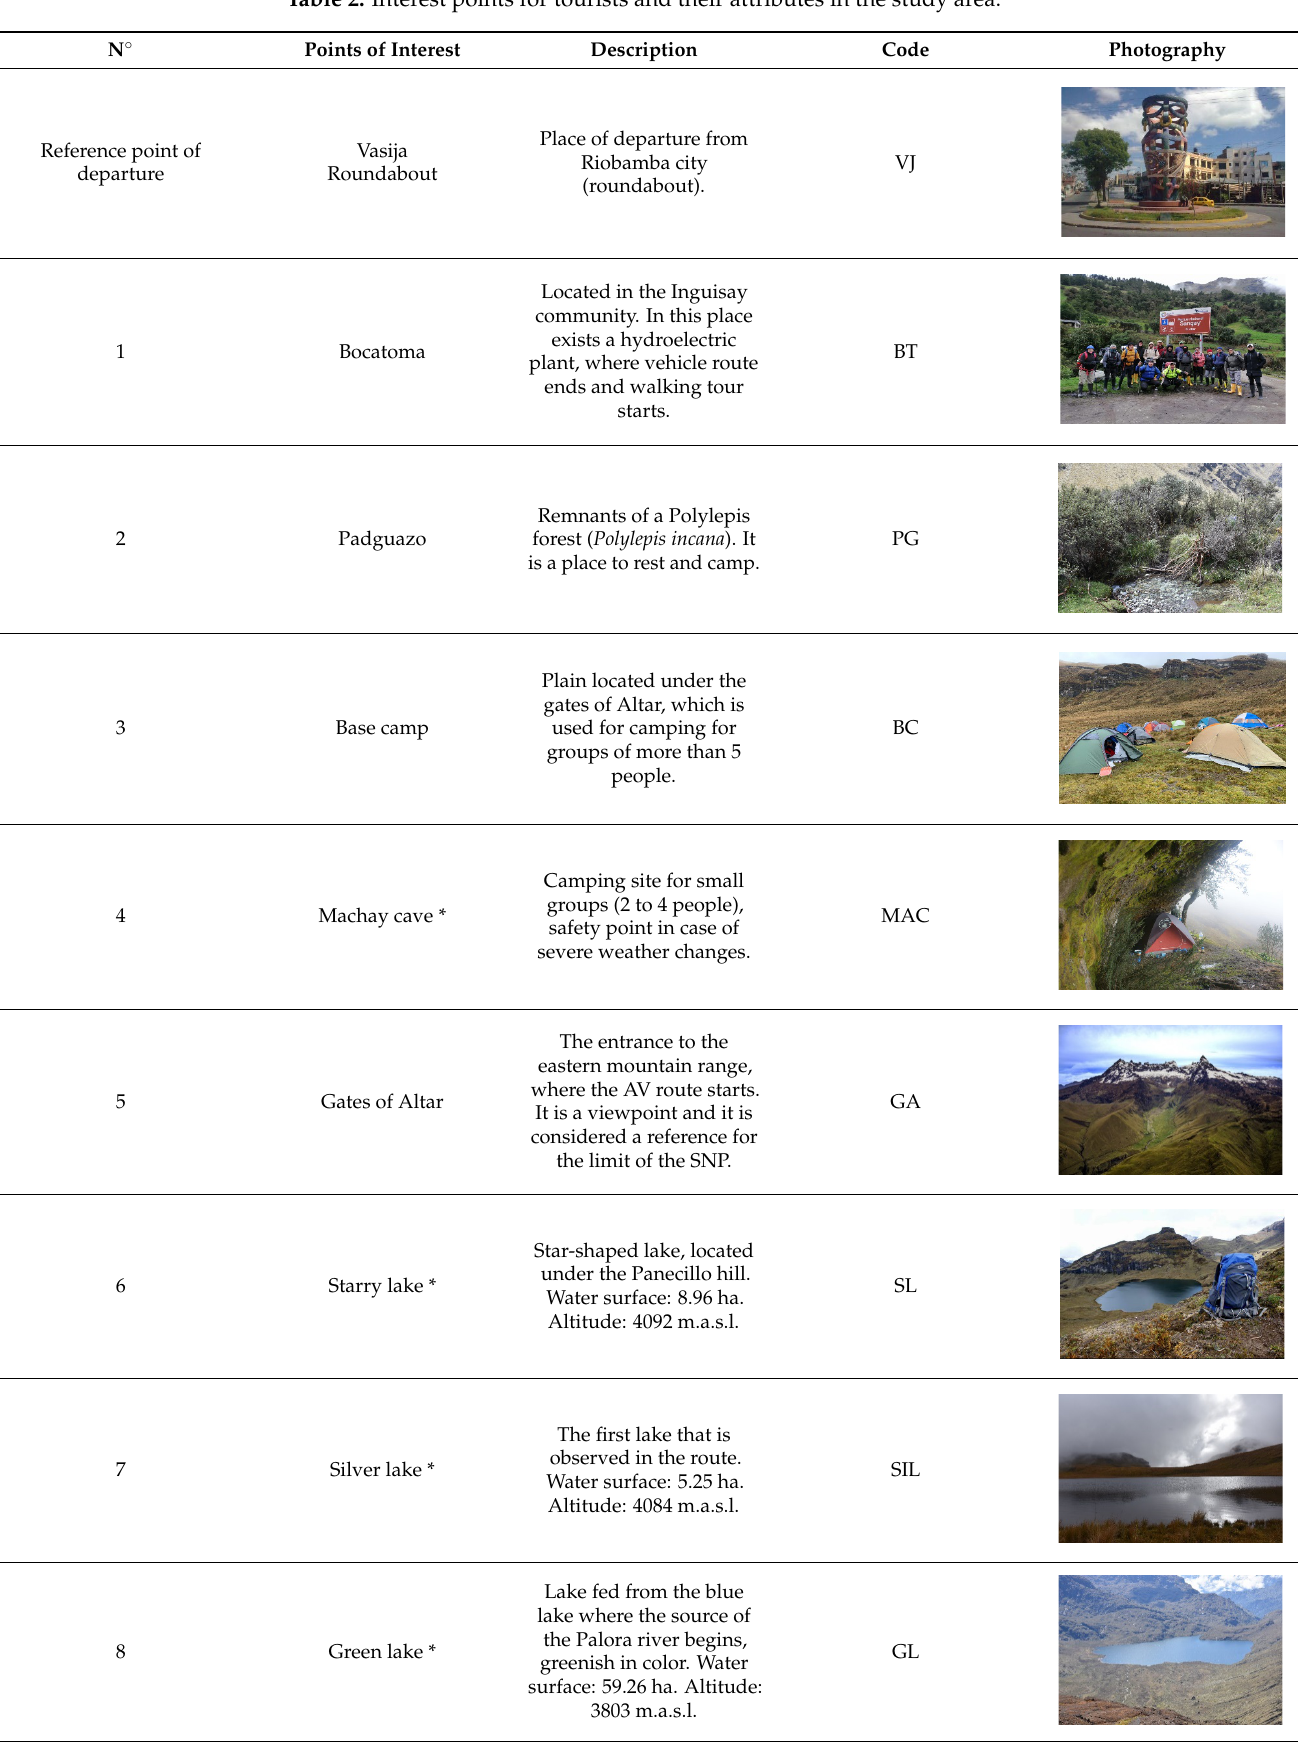
Table 2. Interest points for tourists and their attributes in the study area.